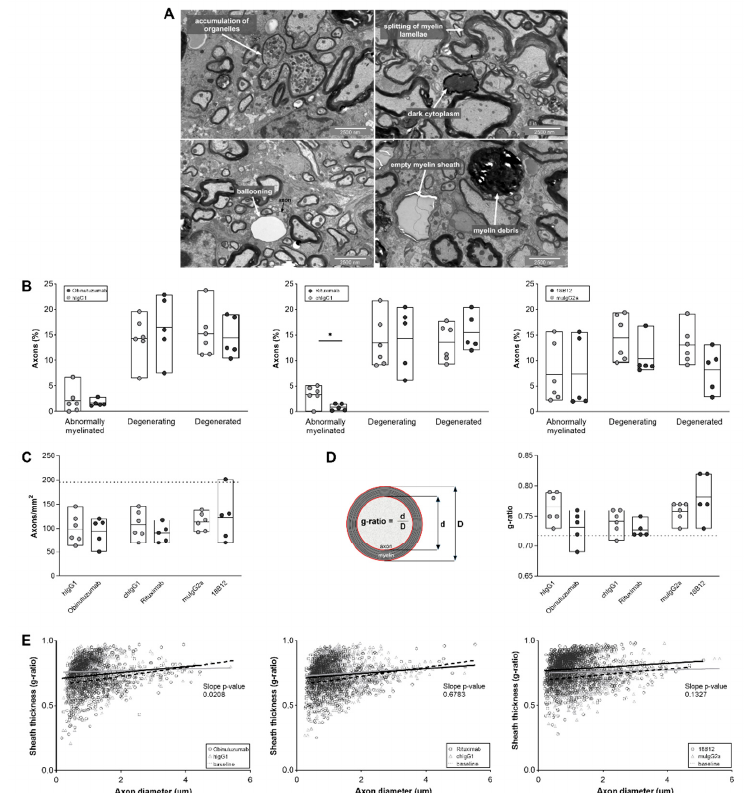
Figure 6. Anti-CD20 mAb treatment effects on ultrastructural spinal cord pathology in hCD20xhIgR3 and WT B6 mice. Spinal cords of mice ( n = 5–6 per group) were dissected 7 days after the final injection of 5 mg/kg anti-CD20 mAbs or corresponding isotype control. ( A ) Representative electron micrographs showing the different categories of nerve fiber degeneration. Splitting and ballooning of myelin lamellae indicate abnormally myelinated axons; accumulation of organelles and dark cytoplasm indicate degenerating axons; and myelin debris and empty myelin sheaths indicate degenerated axons. ( B ) Quantification of axonal degeneration. Each circle represents the mean value of an individual mouse. The bars indicate the group mean value as well as minimum and maximum values. The following statistical tests were used for group comparisons: abnormal axons, unpaired t test (OBZ) and Welch’s t test (RTX, 18B12); degenerating and degenerated axons, Welch’s t test (all groups). * p ≤ 0.05. ( C ) Number of axons per mm 2 . The dotted line marks the baseline value (195 axons/mm 2 ) in healthy mice ( n = 7). Statistical significance was evaluated by unpaired t test. ( D ) The g-ratio was calculated by dividing the diameter of the axon by the diameter of the nerve fiber (axon + myelin sheath) in a mean ± SD of 229 ± 37 randomly selected axons/mouse ( n = 5–6 mice per group). The dotted line represents the baseline value of normally myelinated axons (0.718) ( n = 7; mean ± SD of 13 ± 19 axons/mouse). The bars indicate the group mean value as well as minimum and maximum values. Statistical significance was calculated using unpaired t test. ( E ) Scatter plots showing the myelin sheath thickness of individual myelinated axons as a function of the respective axon diameter with simple linear regression analysis (black line: anti-CD20 mAbs; grey line: isotype controls; dashed line: baseline). The baseline was determined from healthy mice ( n = 7). The significant slope change in the regression analysis of obinutuzumab-treated mice toward the baseline indicates a positive effect of the therapeutic mAb on myelination ( p = 0.0298). Statistical significance was calculated using ANCOVA.